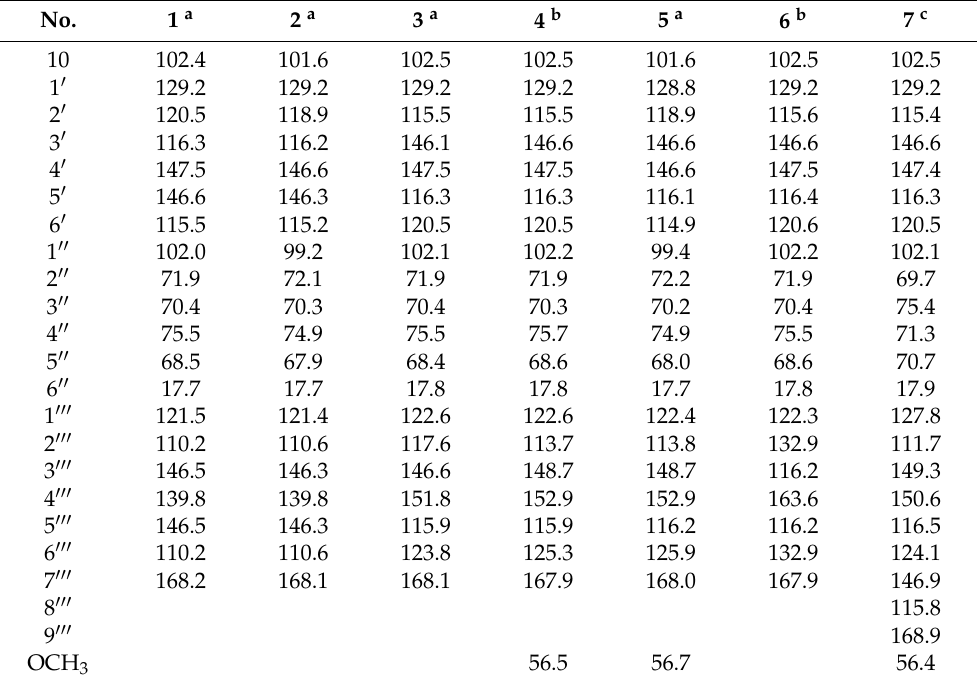
a measured at 100 MHz. b measured at 125 MHz. c measured at 200